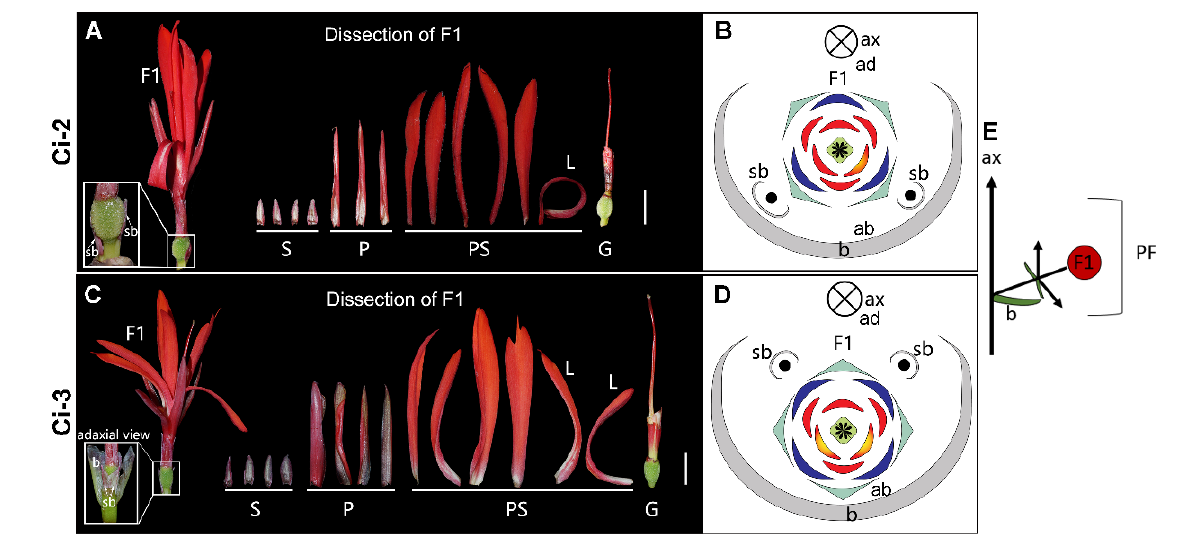
Figure 4. Single flower. ( A ) Photograph and ( B ) diagram of the partial inflorescence of Ci-1. ( C ) Longitudinal scheme of the lateral single flower. Bar = 1 cm.